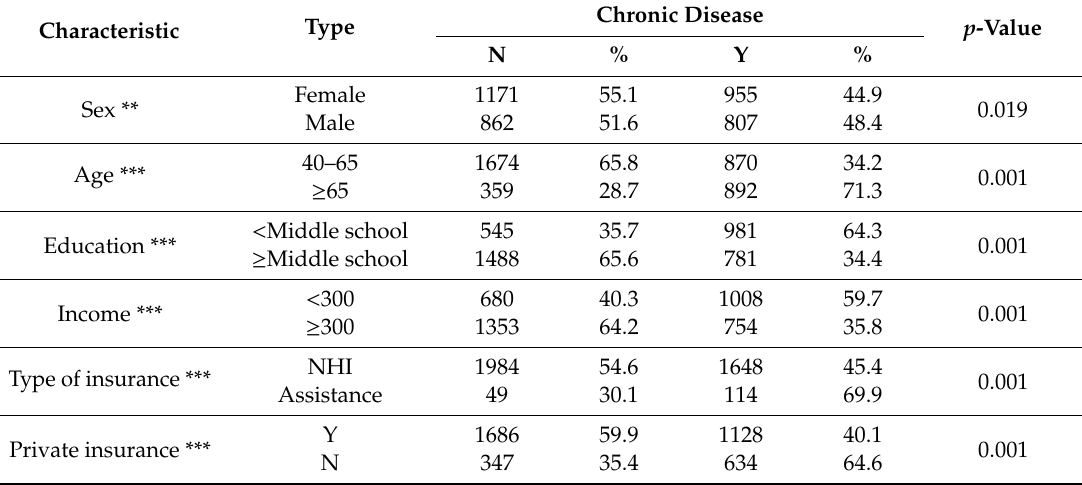
Table 3. Relationship between demographic characteristics and chronic